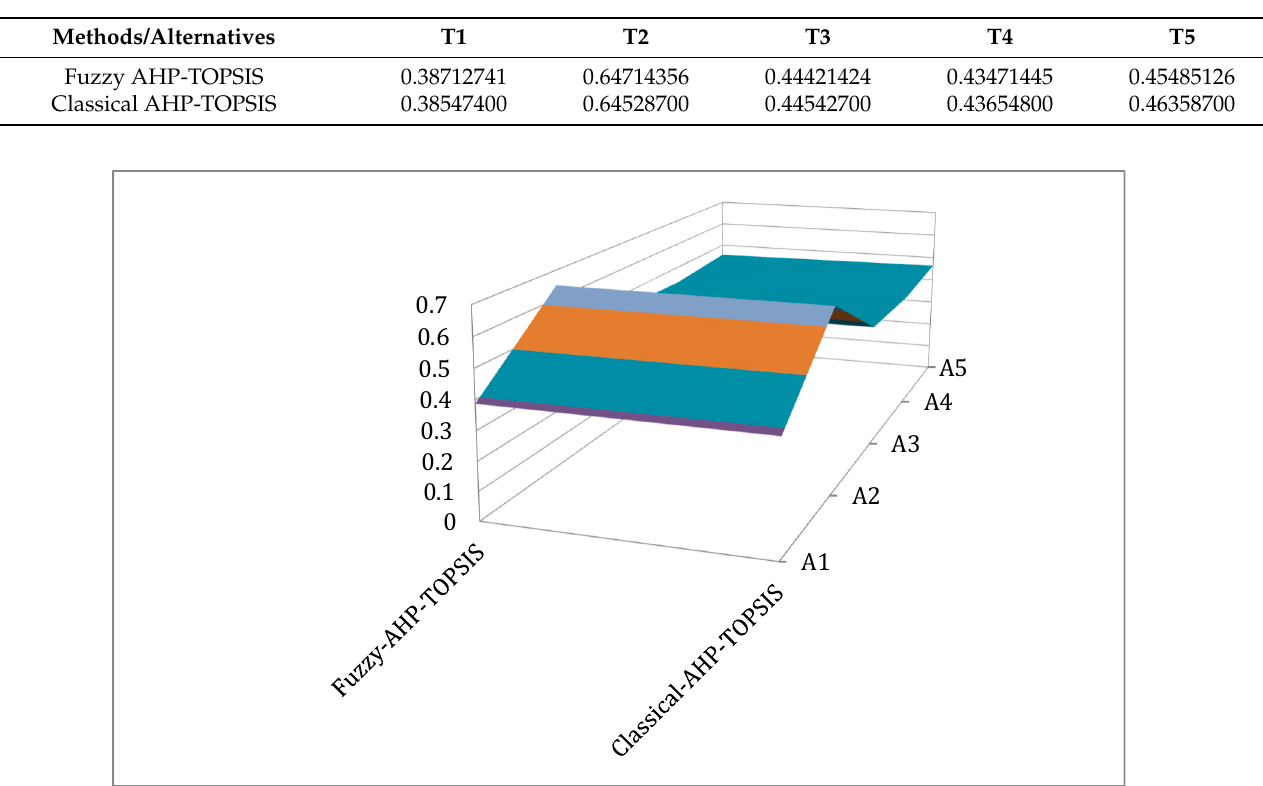
Figure 11. A graphical representation of the comparison of the AHP-TOPSIS